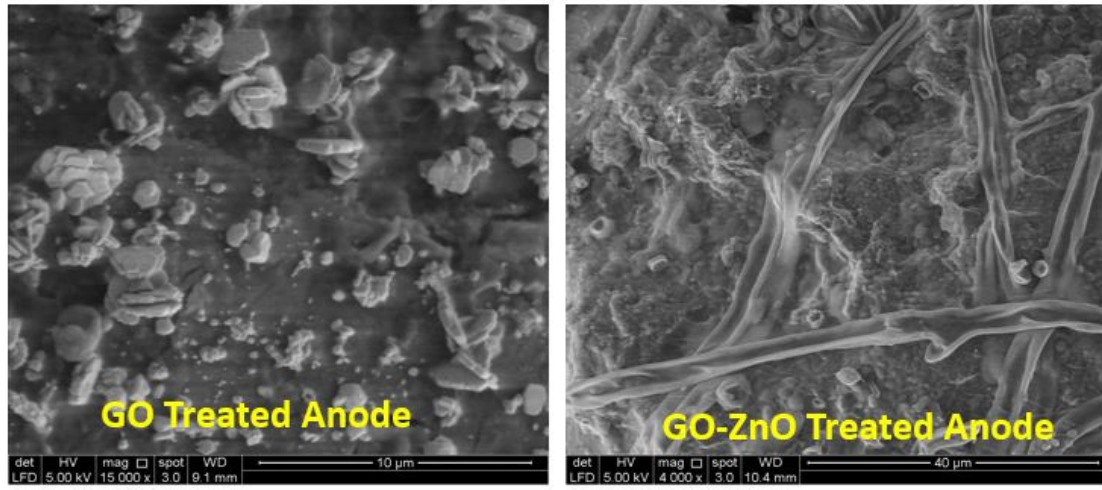
Figure 8. SEM images of treated anodes.